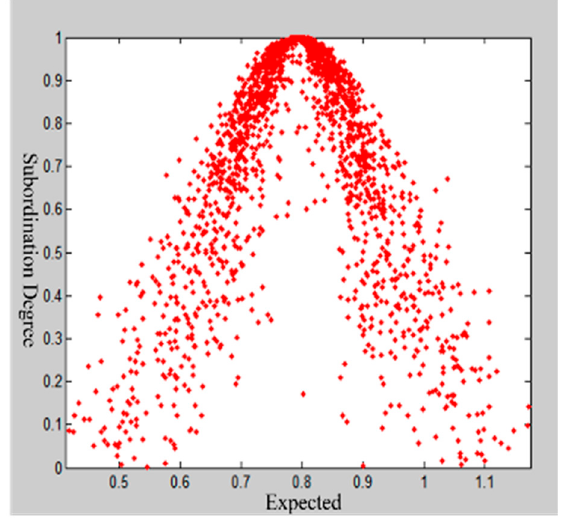
Figure 7. Expert score cloud model restoration chart for the first time.